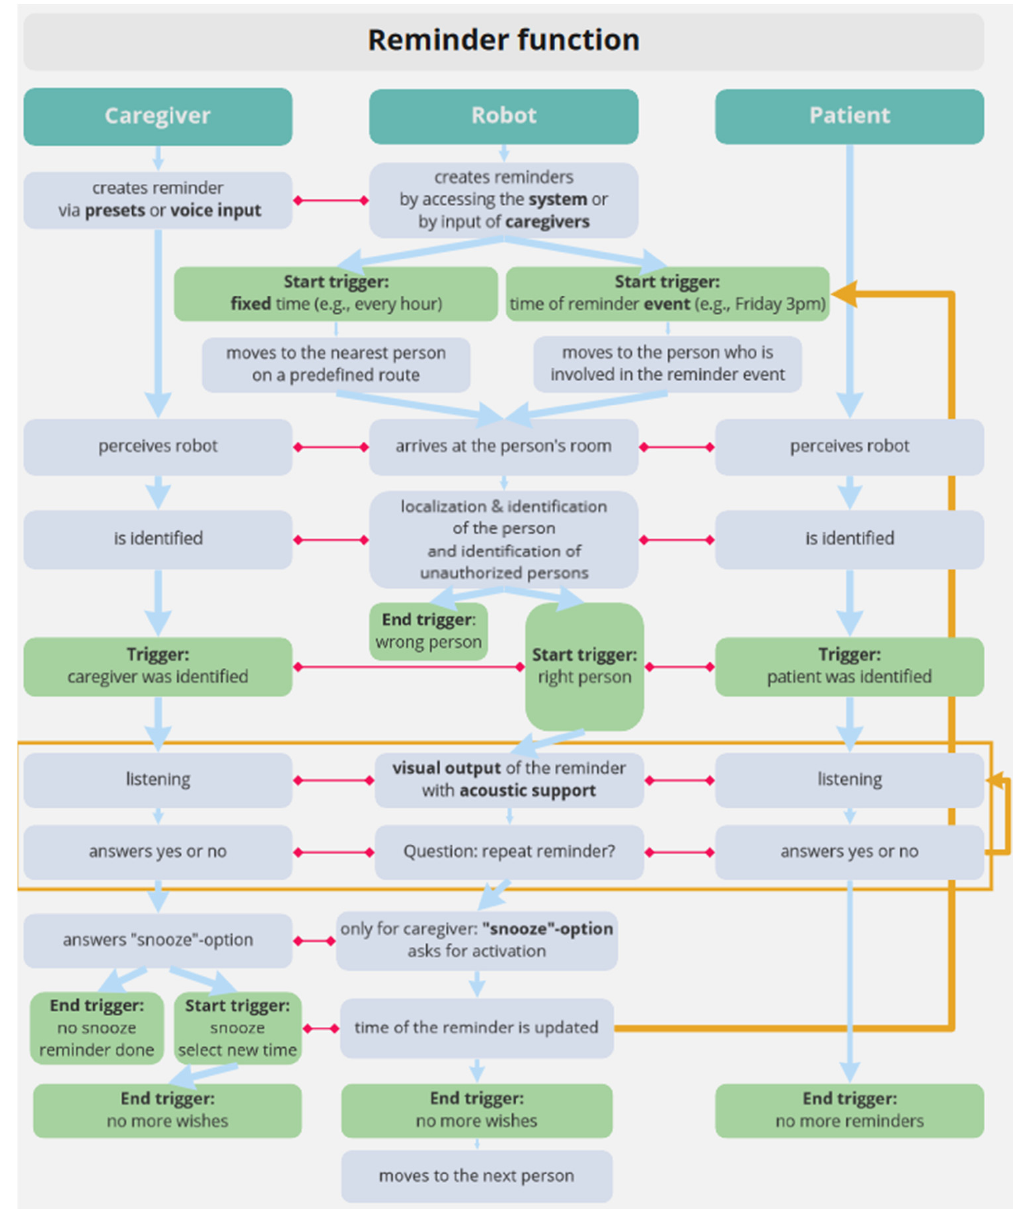
Figure 8. Sequence model of the reminder function.